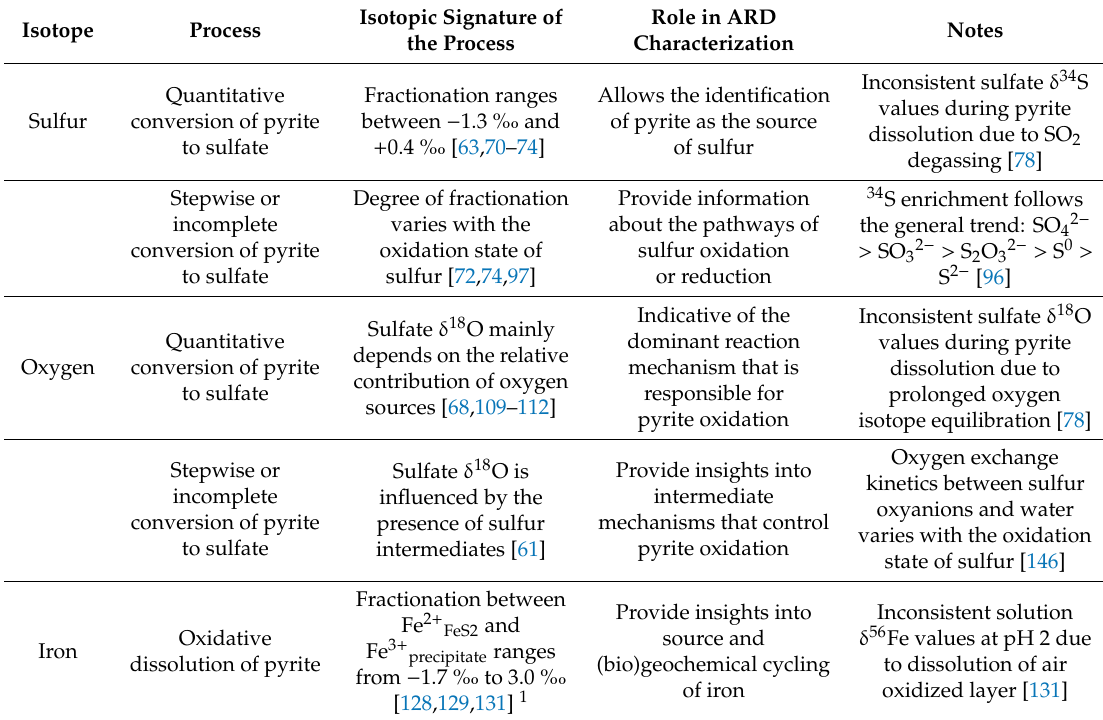
Table 1. Summary of the main isotopic signatures during the oxidative leaching of pyrite